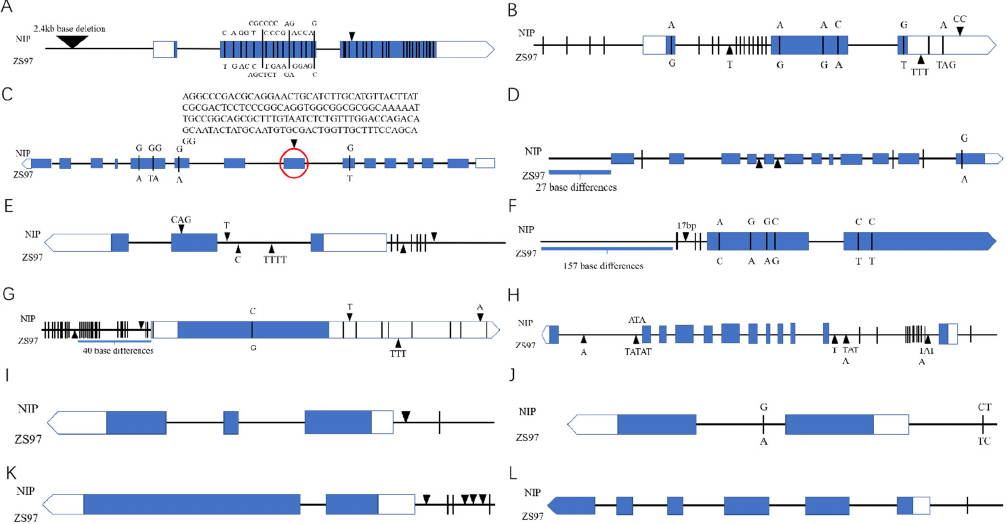
Figure 13. Schematic diagram and sequence variation of 12 candidate genes. ( A ): LOC_Os01g71860; ( B ): LOC_Os04g33640; ( C ): LOC_Os04g39864; ( D ): LOC_Os04g52210; ( E ): LOC_Os04g52504; ( F ): LOC_Os04g53630; ( G ): LOC_Os04g48290; ( H ): LOC_Os04g43410; ( I ): LOC_Os04g44500; ( J ): LOC_Os04g44150; ( K ): LOC_Os04g43800; ( L ): LOC_Os04g44580. The blue box represents exons; the blank arrow represents 3′-UTR. The black triangle represents INDEL (triangle indicates insertion in NIP while inverted triangle indicates insertion in ZS97 sequence). The black line represents SNP.A, B, C, D, E, F, G: Genes with changes in the coding region (with changes at the protein level). H, I, J, K, L: Genes with changes in promoters/introns.